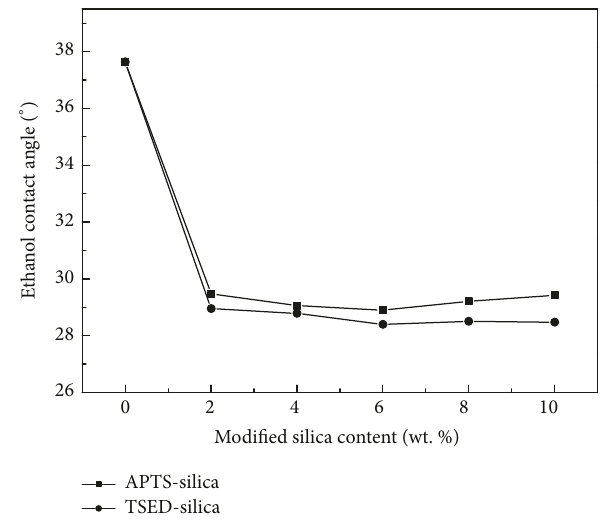
Figure 5: Contact angle of water at the surface of modified PDMS membranes.